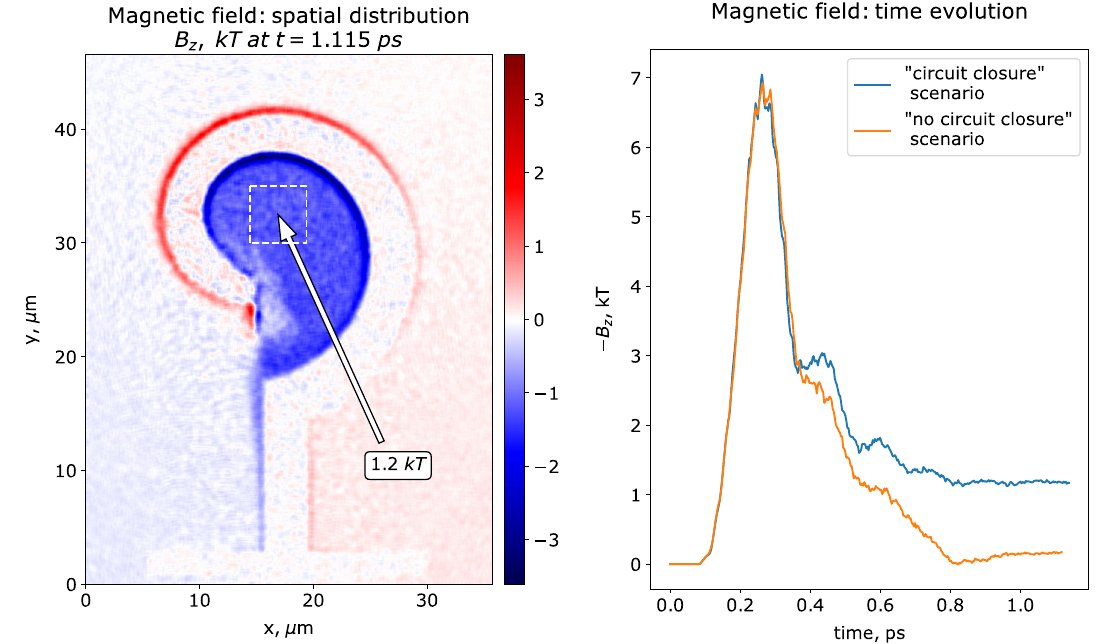
Figure 5. Results of 2D PIC simulations. Left panel: spatial distribution of magnetic field ≈ 0.75 ps after the end of the laser pulse, averaged spatially with a Gaussian kernel of ≈ 0.5 µ m to reduce visual noise. Right panel: time evolution of the magnetic field inside the ’snail’ cavity for two different scenarios of magnetic field generation, showing that the generated magnetic field evolves towards stationary distribution if the circuit is closed before the spatial distribution